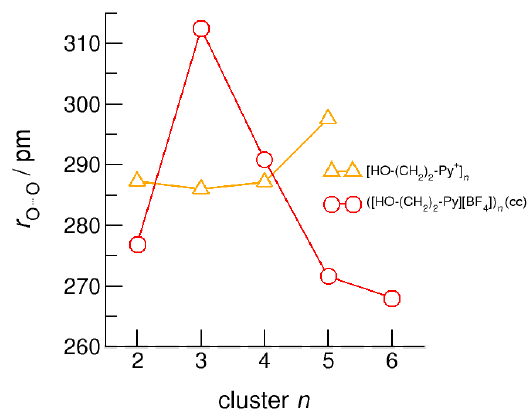
Figure 13. Average intermolecular bond lengths, r (O ... O), for the cationic clusters [HO-(CH 2 ) 2 -Py + ] n (triangles) and neutral clusters ([HO-(CH 2 ) 2 -Py][BF 4 ]) n (c–c) (circles) calculated at the B3LYP-D3/6–31+G* level of theory [24].